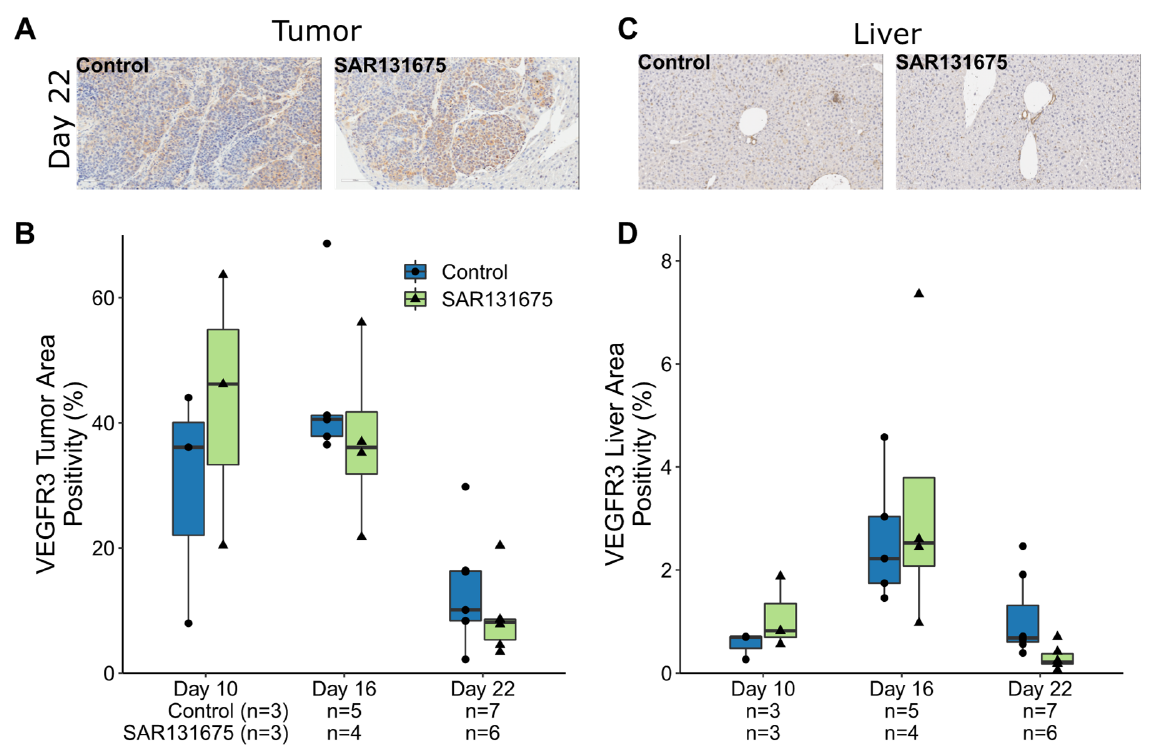
Figure 4. VEGFR3 staining in tumor and liver parenchyma . Representative IHC images of VEGFR3 staining cells (brown staining) in control and SAR13675 treated tumor ( A ) and liver ( C ) sections. ( B ) Enumeration of VEGFR3 positively staining in the tumor as a percentage of total tumor area. ( D ) Enumeration of VEGFR3 positively staining in liver as a percentage of total liver area. 3.5. SAR131675 Treatment Significantly Alters the Balance of Lymphocytes and Myeloid